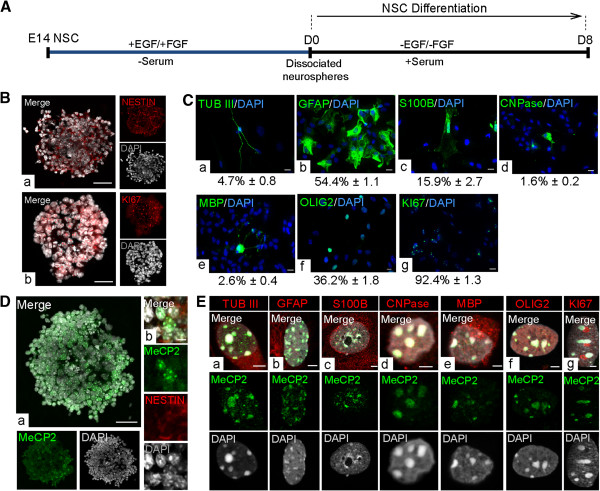
Characterizing in vitro neural stem cells to study Methyl CpG binding protein 2 (MeCP2) expression. (A) Schematic representation of in vitro neural stem cell (NSC) differentiation. (B) Detection of (a) NESTIN+ and (b) KI67+ cells in self-renewing neurospheres. Scale bars represent 20 μm. (C) Immunofluorescent detection of different cell-type markers in the day 8 (D8) population (a) TUBULIN III (TUB III): neurons, (b) Glial fibrillary acidic protein (GFAP): astrocytes, (c) S100B: mature astrocytes, (d) 2',3'-Cyclic-nucleotide 3'-phosphodiesterase (CNPase): oligodendrocytes, (e) Myelin basic protein (MBP): oligodendrocytes, (f) Oligodendrocyte lineage transcription factor 2 (OLIG2): early oligodendrocytes and progenitors, and (g) KI67: proliferating cells. Scale bars represent 10 μm. The percentages represent average number of cells from three individual experiments (n = 3 ± standard error of the mean). (D) (a) Immunofluorescent detection of MeCP2 in a sectioned primary neurosphere. Scale bar represents 20 μm. (b) Double labeling of MeCP2 and NESTIN within primary neurosphere cells. Scale bar represents 5 μm. (E) Immunofluorescent detection of MeCP2 in D8 cell types: (a) TUB III, (b) GFAP, (c) S100B, (d) CNPase, (e) MBP, (f) OLIG2, and (g) KI67. Scale bars represent 2 μm.